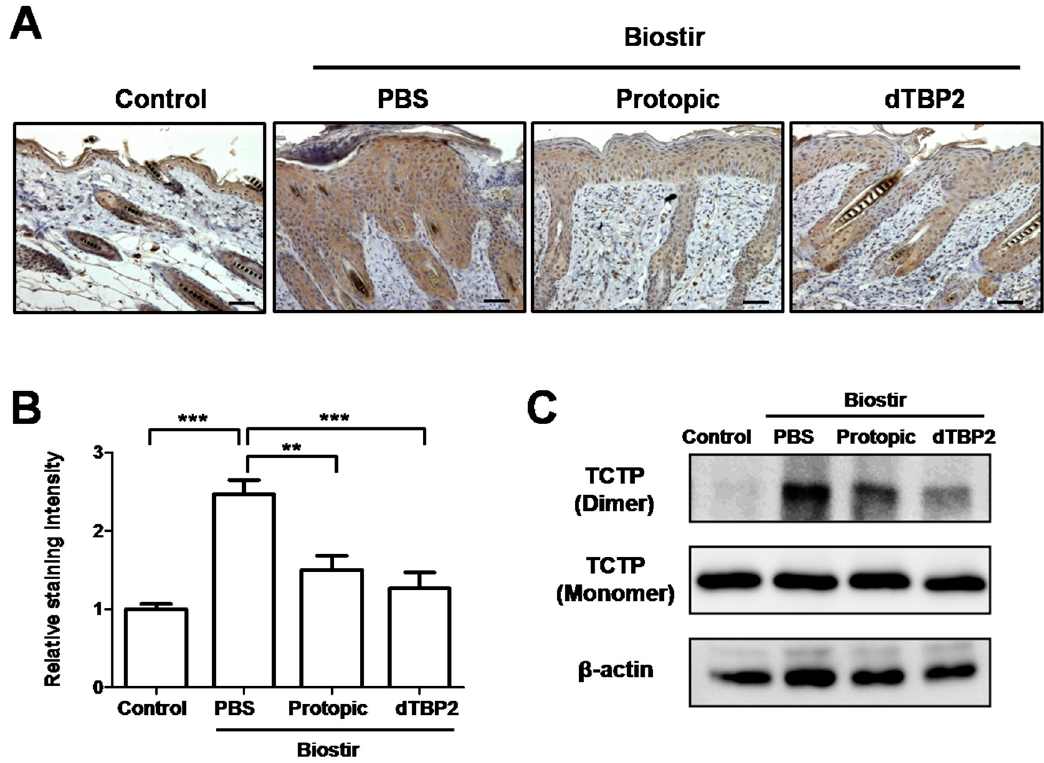
Figure 5. dTBP2 suppresses level of dTCTP in AD-like skin lesions. ( A ) Dorsal skin sections were stained by immunohistochemistry using mouse monoclonal anti-TCTP antibody. Immunolocalization of TCTP in AD-like skin lesions was examined under microscope. Scale bar = 50 μ m; ( B ) The relative staining intensity was calculated using ImageJ software. The relative staining intensities are expressed as the mean ± SEM ( n = 5 sections each). ** p < 0.001, *** p < 0.0001, treatment group compared with Biostir- PBS group; ( C ) Total protein was isolated from dorsal skin tissues from experimental mice and the expression of TCTP was analyzed by western blot using anti-TCTP